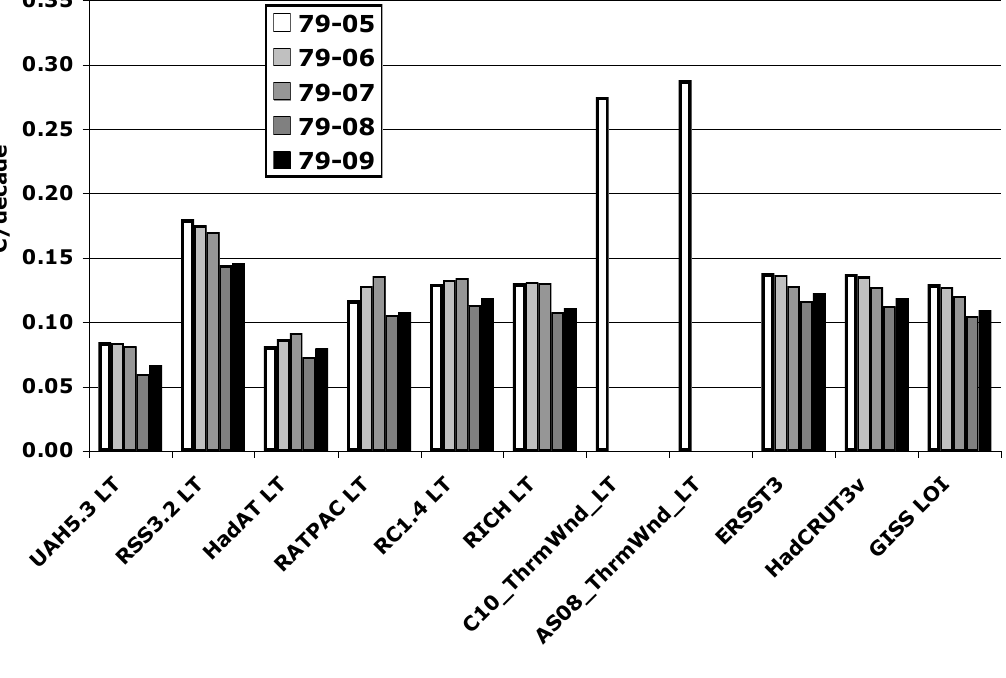
(left 8) and T (right 3) datasets used in the paper. All LT sfc